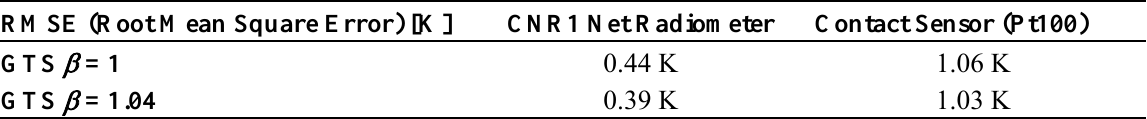
Table 7. GTS compared with CNR1 net radiometer and contact sensor for the 25th of January data.